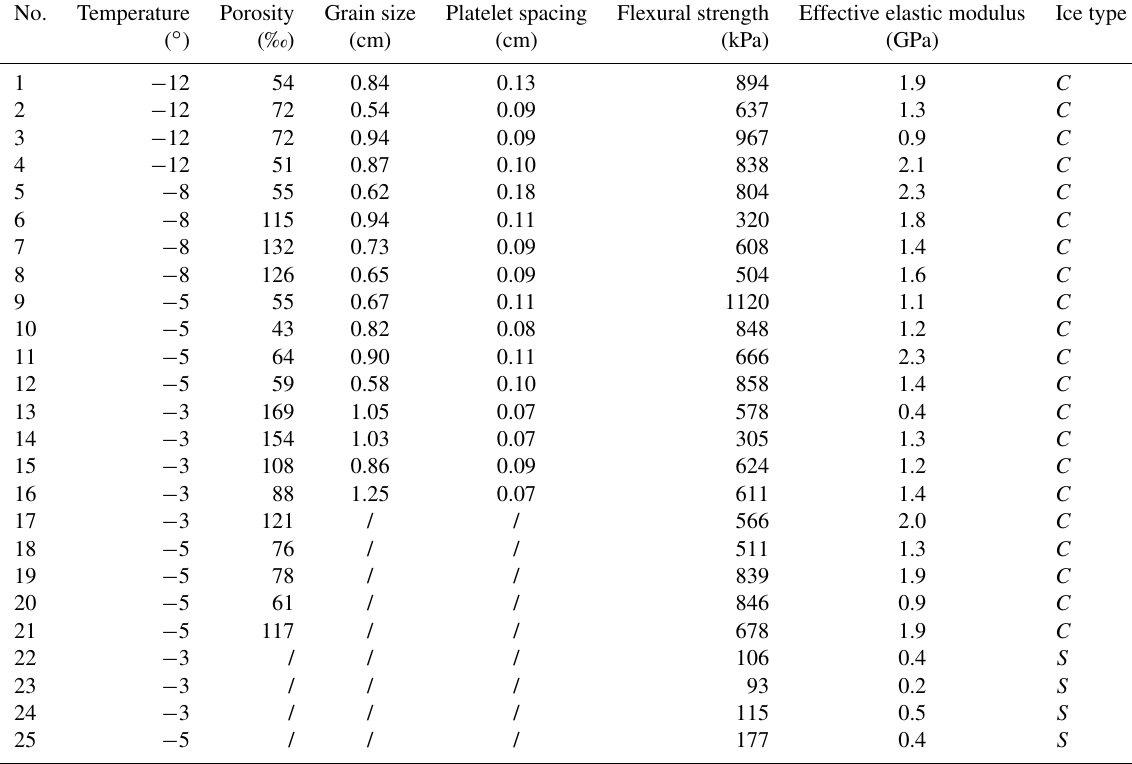
Table A1. Detailed information of bending test